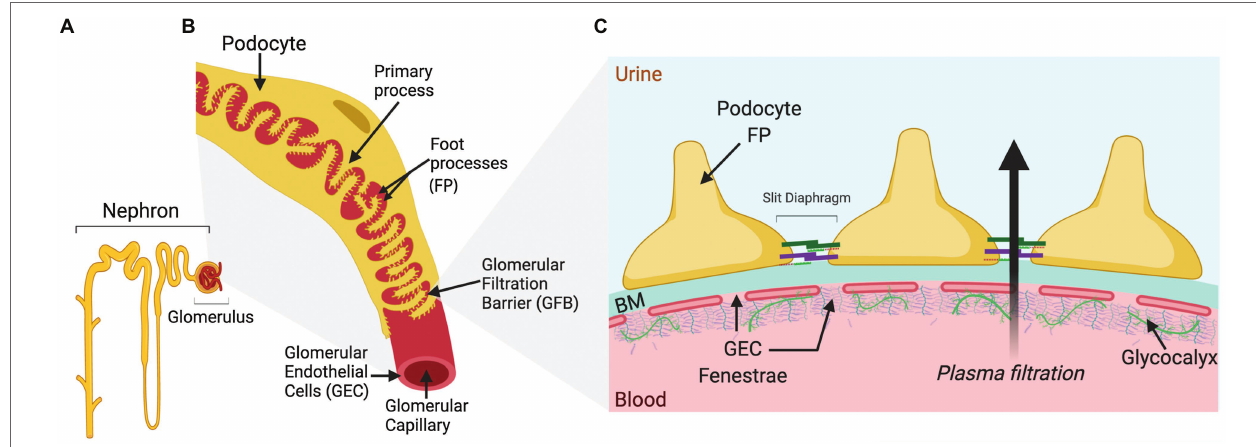
FIGURE 1 | Schematic drawing of a single nephron and glomerulus, a glomerular capillary vessel, and the glomerular filtration barrier (GFB). (A) A single nephron comprising the blood-filtering glomerulus, enveloped by Bowman’s capsule that connects to the proximal tubule at the start of the urine-modifying tubular system. (B) The luminal surface of the glomerular capillary vessel is covered by glomerular endothelial cells (GECs), while podocytes wrap around the outside of the vessel with primary and foot processes (FT), forming an interdigitated pattern. Neighboring FPs are bridged by the slit diaphragm, one of the several essential components for glomerular permselectivity. The blood is filtered over this capillary barrier, and the pre-urine produced is forwarded from the Bowman’s capsule into the lumen of the proximal tubule. (C) The schematic cross section of the GFB displays the GEC fenestrae attached to the basement membrane (BM) and covered luminally by glycoproteins, proteoglycans, and glycosaminoglycans of the glycocalyx, important for maintaining the charge selectivity of the GFB. On the opposite side of the BM, the podocyte FPs are attached. The FPs interlink by slit diaphragm proteins, such as nephrin and podocin, are important for the restriction of albumin by the GFB. The arrow shows the direction of plasma filtration over the